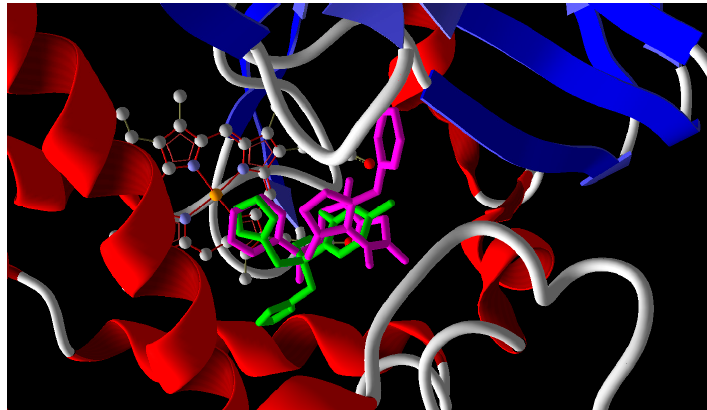
Figure 5. Overlay of Compound 10 (purple) and fluconazole (green) in the groove of cytochrome P450 14- α -sterol demethylase (Red: alpha helix Blue: Beta sheet).